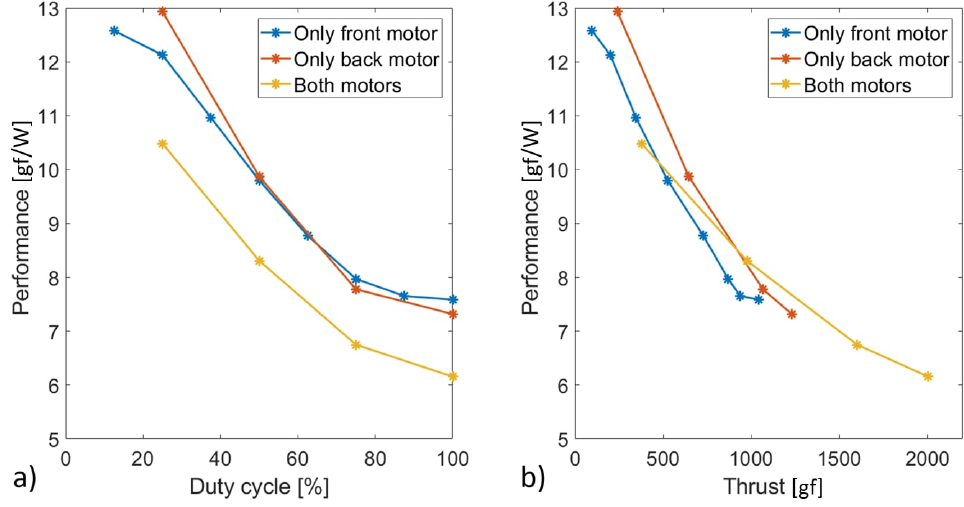
Figure 9. System performance for individual rotor runs compared to combined operation against ( a ) duty cycle and ( b ) total thrust